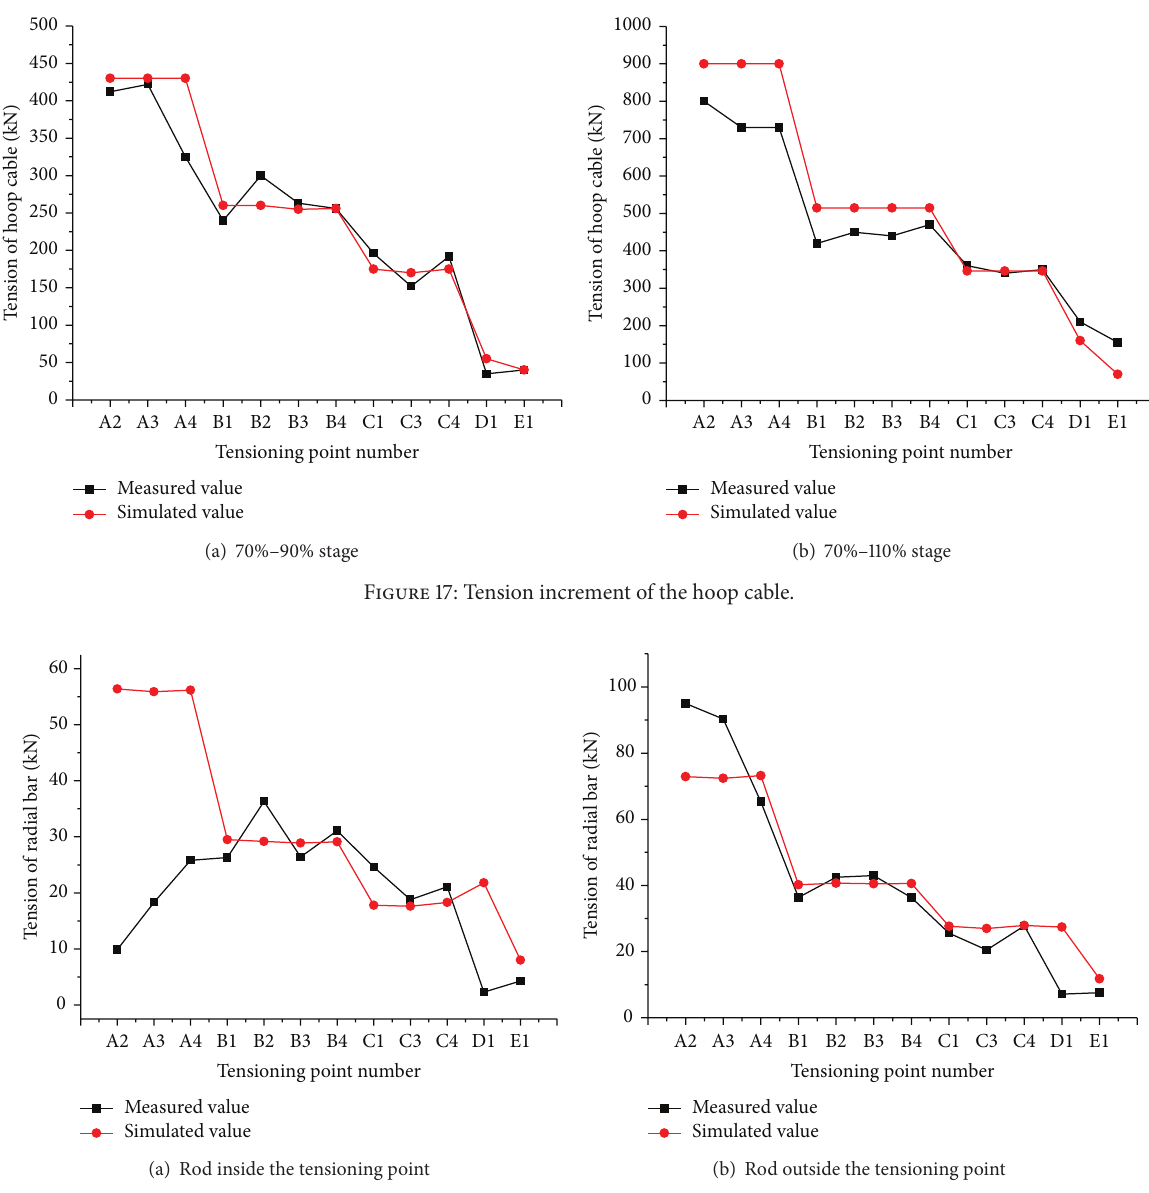
Figure 18: Tension increment of the radial bar in the 70%–90%